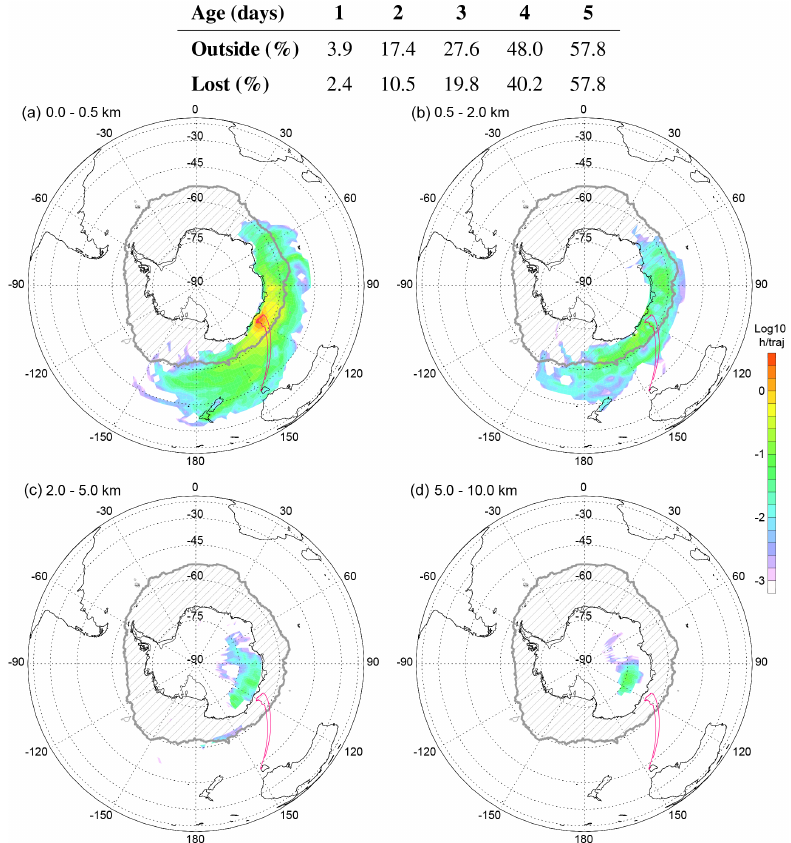
Figure 7. Five-day forward trajectories released from SIPEXII locations and times and passing through the following atmospheric layers: (a) the first 500m, (b) 500m to 2km, (c) 2 to 5km and (d) 5 to 10km. The ice edge and ship track are shown for reference, while colours reflect the percentage, in log scale, of trajectories released which pass through a given grid box. The table above classifies, as a function of days after release, the percentage of the total number of trajectories either outside (those outside the sea-ice edge on the given day) or lost (those which do not re-enter the sea-ice zone after the given number of